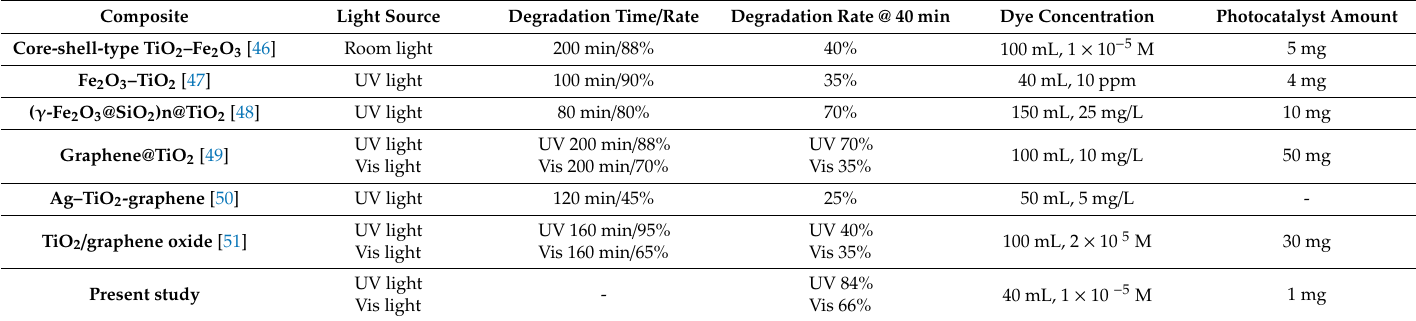
Table 2. Photocatalytic degradation of MB over di ff erent composite photocatalysts, including Fe 2 O 3 and graphene, in comparison to present case.